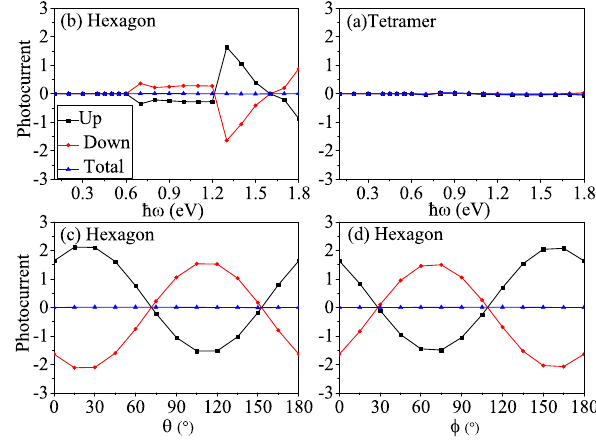
Figure 2: The spin dependent photocurrents of: (a) Junction C6 and (b) Junction C4 as a function of photon energy ℏ𝜔 under linearly polarize light with polarization angle 𝜃 = 0 ˚ . The spin dependent photocurrents of Junction C6 as a function of: (c) polarization angle 𝜃 under linearly polarized light and (d) helicity angle 𝜙 under elliptically polarized light, with the photon energy taken as ℏ𝜔 = 1 . 3 eV as an